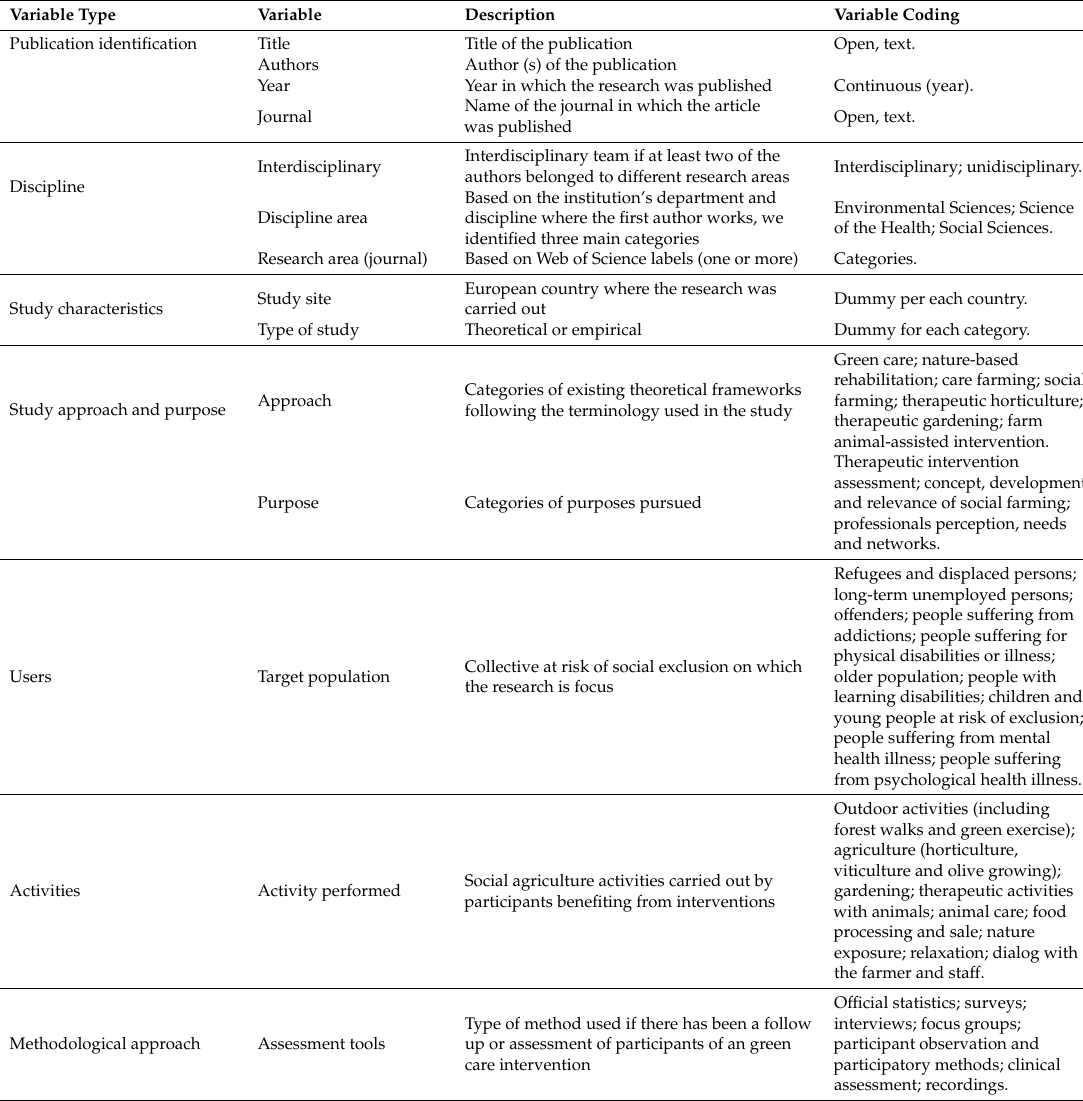
Table 1. List of variables extracted from the